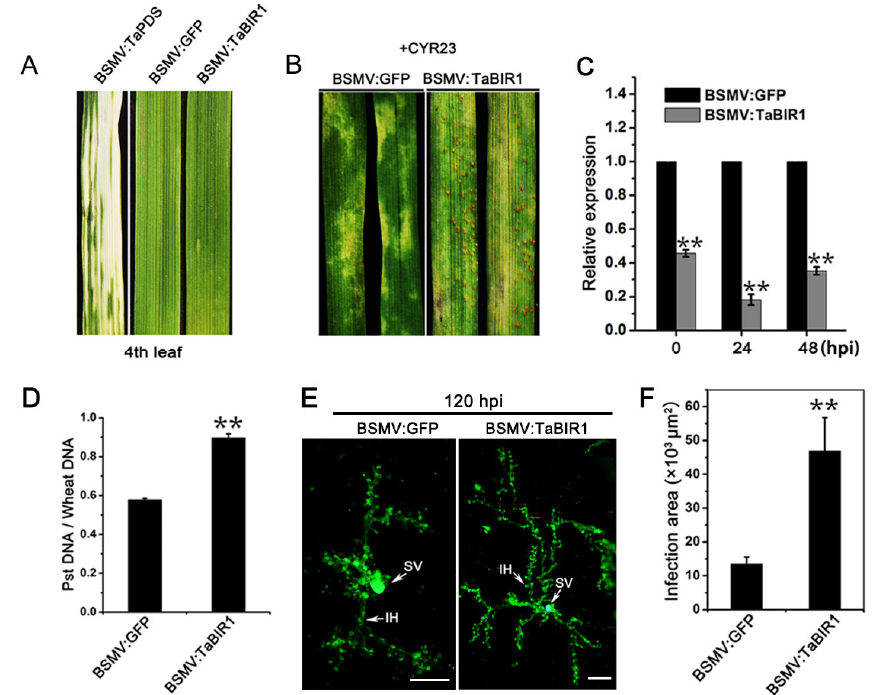
Figure 3. Transient silencing of TaBIR1 via VIGS compromised wheat resistance to stripe rust. ( A ) Symptoms on the fourth leaves of wheat seedlings inoculated with BSMV: TaPDS , BSMV: GFP (negative control) and BSMV: TaBIR1 . The second leaves of wheat cultivar Su11 were inoculated with recombinant BSMV and the virus phenotype were taken at 12 days post-inoculation (dpi). ( B ) Disease phenotypes of TaBIR1 -silenced plants inoculated with Pst race CYR23 observed at 16 dpi. At 12 days post BSMV infection, the fourth leaves of wheat seedlings inoculated with BSMV: GFP and BSMV: TaBIR1 were further challenged with avirulent Pst race CYR23. ( C ) Silencing efficiency of TaBIR1 in TaBIR1 -silenced plants at 0, 24 and 48 h post-inoculation (hpi) by qRT-PCR. ( D ) Relative Pst biomass in TaBIR1 -silenced plants at 10 dpi. PsEF and TaEF were used as the internal reference genes. ( E ) Histological observation of Pst fungal development in TaBIR1 -silenced plants at 120 hpi. SV, substomatal vesicle; IH, infection hyphae. Bars, 50 µm. ( F ) Pst infection area per infection site in TaBIR1 -silenced plants at 120 hpi. In ( C , D , F ), asterisks indicate significant differences compared with controls using Student’s t -tests (** p < 0.01).